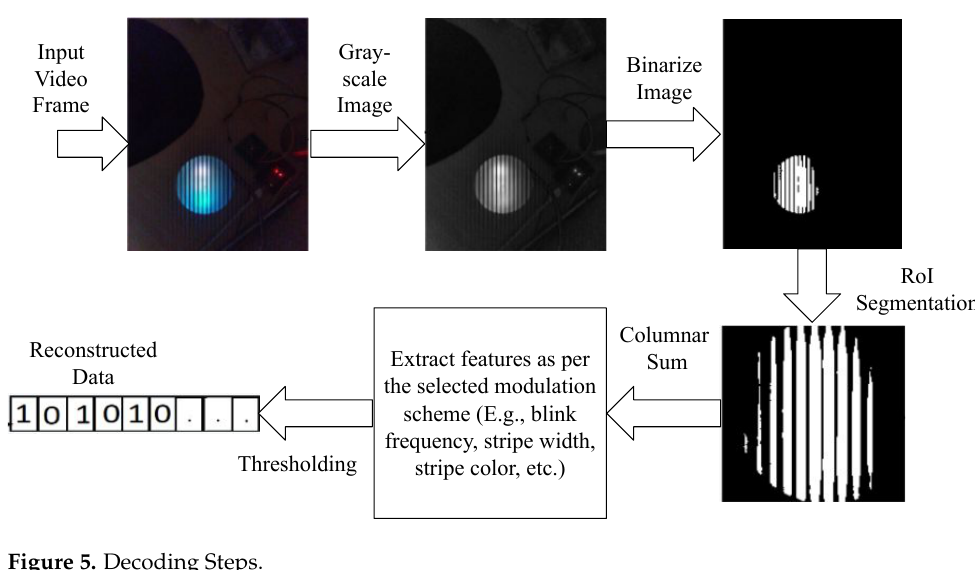
Figure 5. Decoding